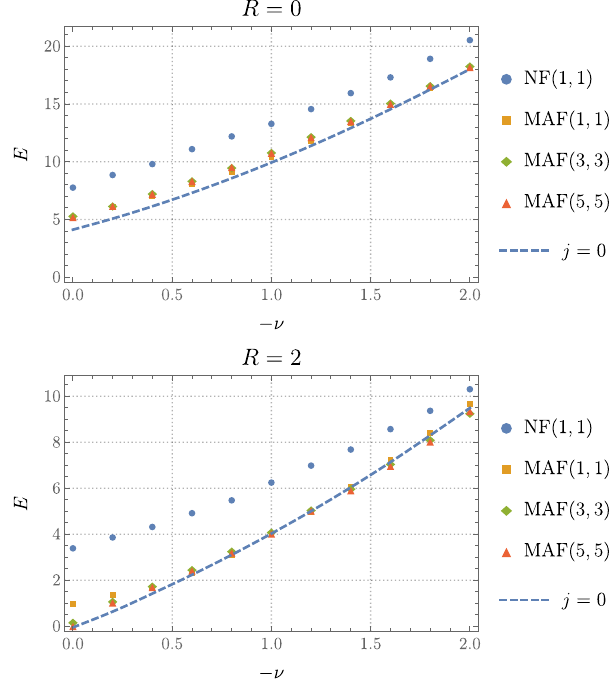
FIG. 1. Benchmarking the architecture: Variational ground- state energies for the mini-BMN model with N ¼ 2 and fermion numbers R ¼ 0 and R ¼ 2 (shown as dots) compared to the exact ground-state energy in the j ¼ 0 sector, obtained in Ref. [34] (shown as the dashed curve). Uncertainties are at or below the scale of the markers; in particular, the variational energies slightly below the dashed line are within the numerical error of the line. NF stands for normalizing flows and MAF for masked autore- gressive flows. As described in the main text, the numbers in the brackets are, first, the number of layers in the neural networks and, second, the number of generalized normal distributions in each base